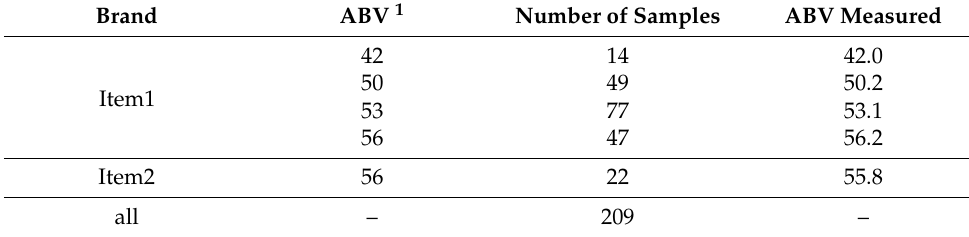
Table 3. ABV of baijiu